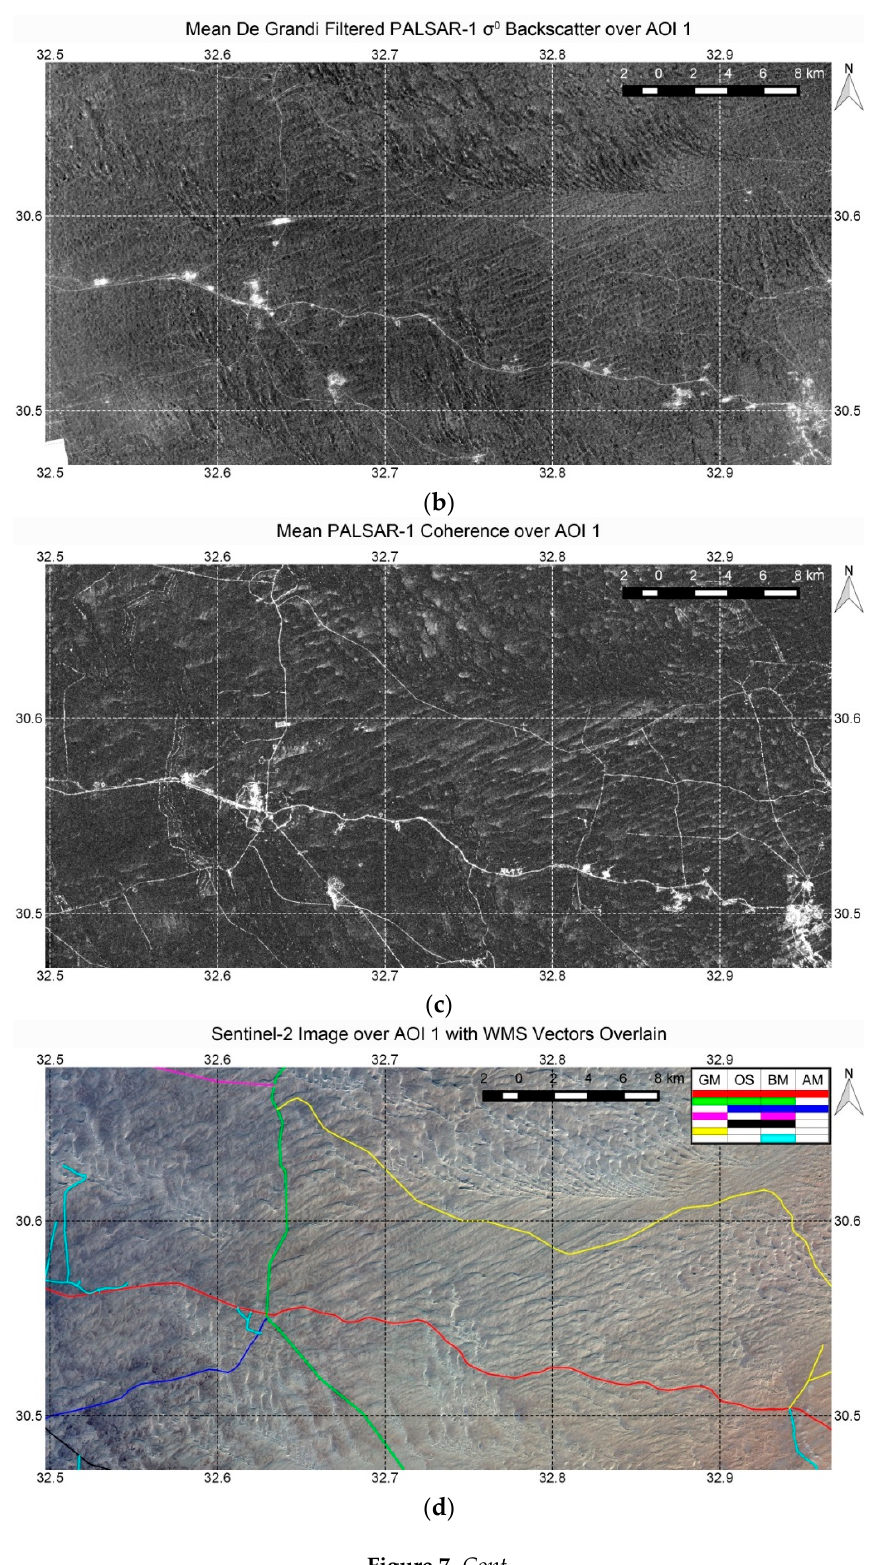
Figure 7. Cont. Figure 7.